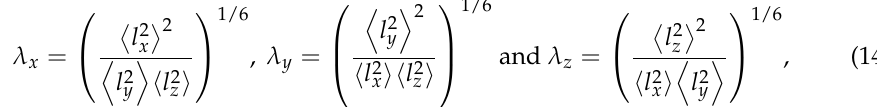
Figure 3. Components of the order parameter tensor S ββ as functions of the parameter w y at V 5 ( a ) and 25 ( b ). V 0 /kT = 5 ( a ) and 25 ( b